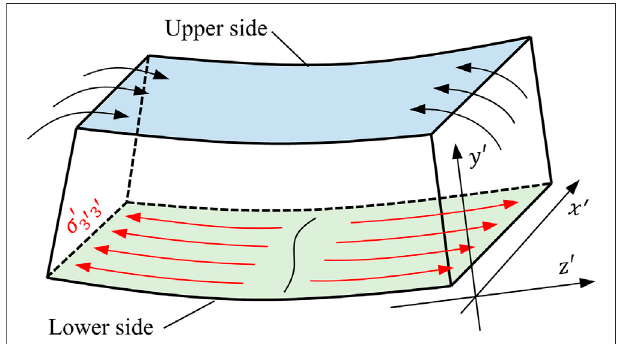
FIGURE 4 | Bending failure of a rock column.